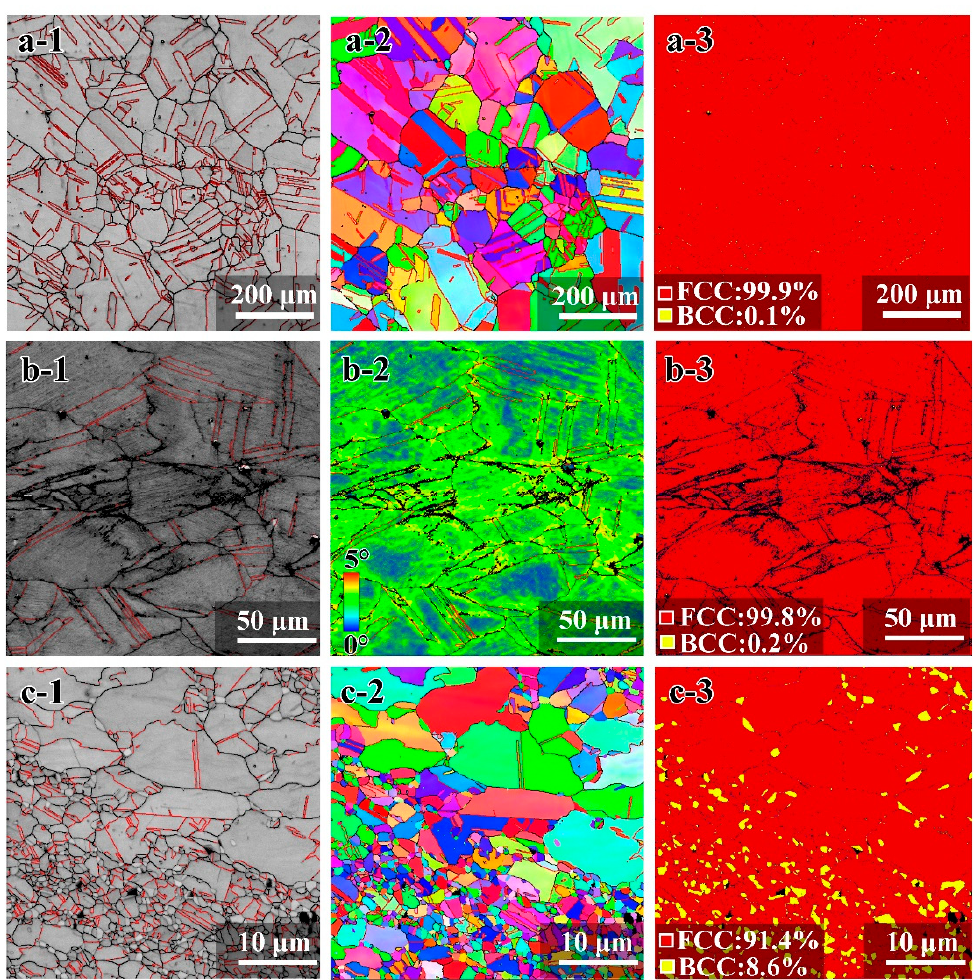
Figure 2. The EBSD images for the CG 1 sample: ( a-1 ) Image with high-angle grain boundaries (GBs) and TBs; ( a-2 ) Inverse Pole Figure (IPF) image; ( a-3 ) Phase image. The EBSD images for the CR sample: ( b-1 ) Image with high-angle GBs and TBs; ( b-2 ) KAM image; ( b-3 ) Phase image. The EBSD images for the HS 2 sample: ( c-1 ) Image with high-angle GBs and TBs; ( c-2 ) IPF image; ( c-3 ) Phase image.